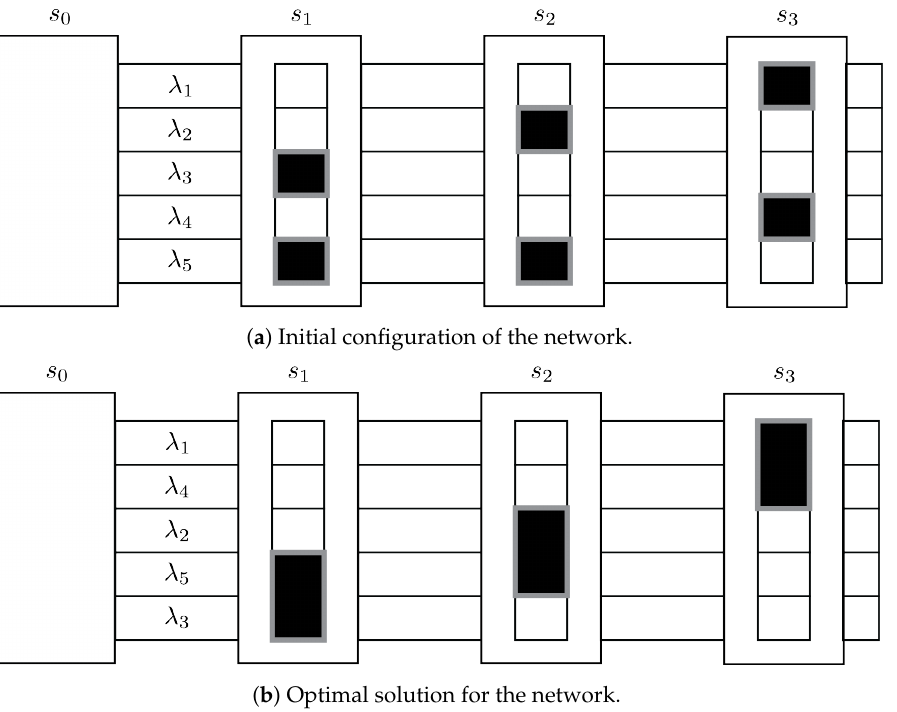
Figure 1. Initial and optimal configuration for a given set of 5 wavelengths and 3 target